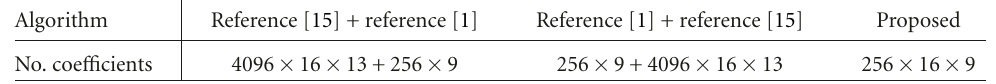
Table 2: Comparison of numbers of coe ffi cients in the LUT of the three algorithms.